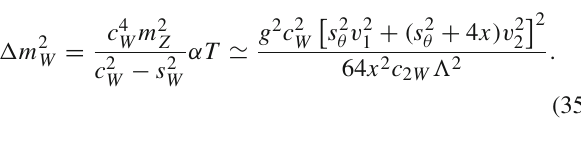
with the aid of m W = m Z c W and m Z